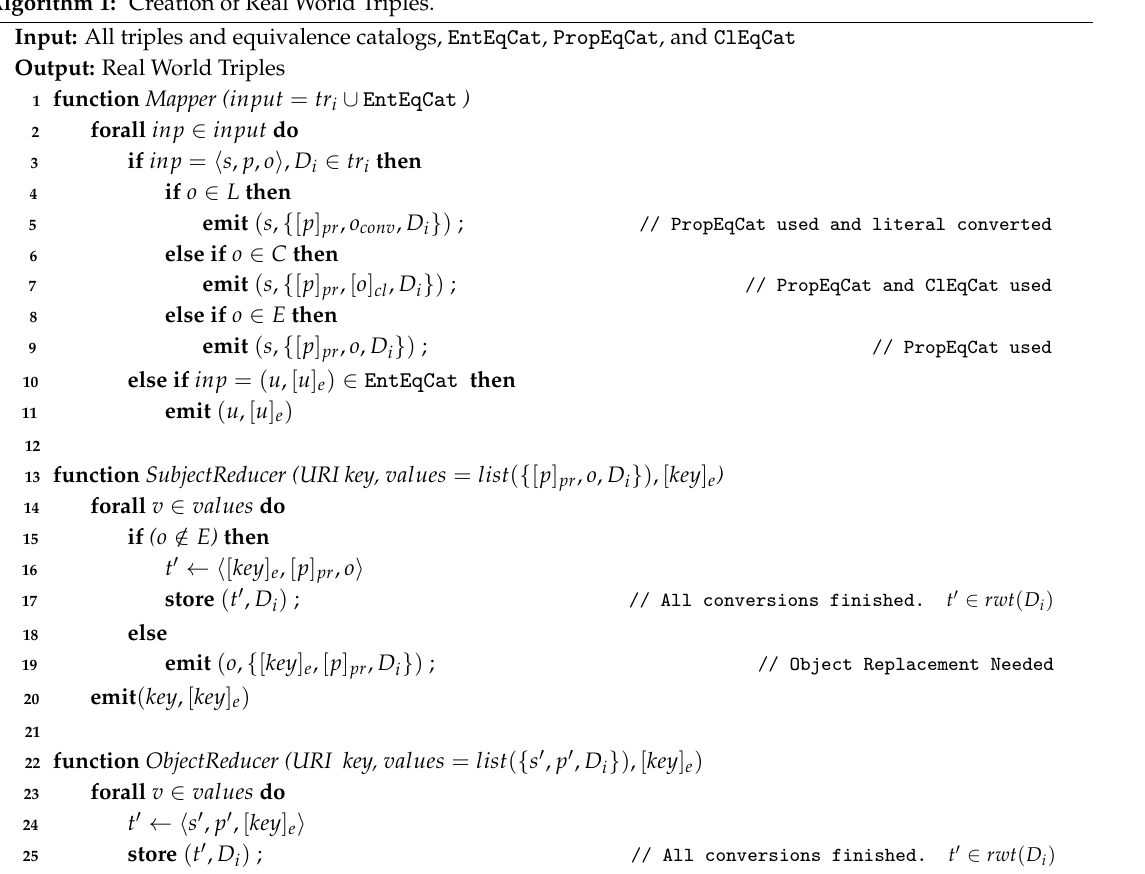
Algorithm 1: Creation of Real World